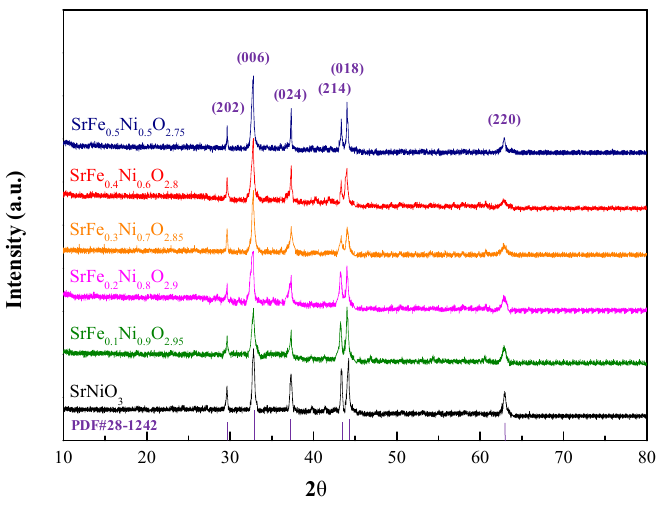
Figure 12. XRD patterns of SrFe x Ni 1− x O 3−δ. Table 4. The relative content of elements in SrFe 0.3 Ni 0.7 O 2.85 perovskite.